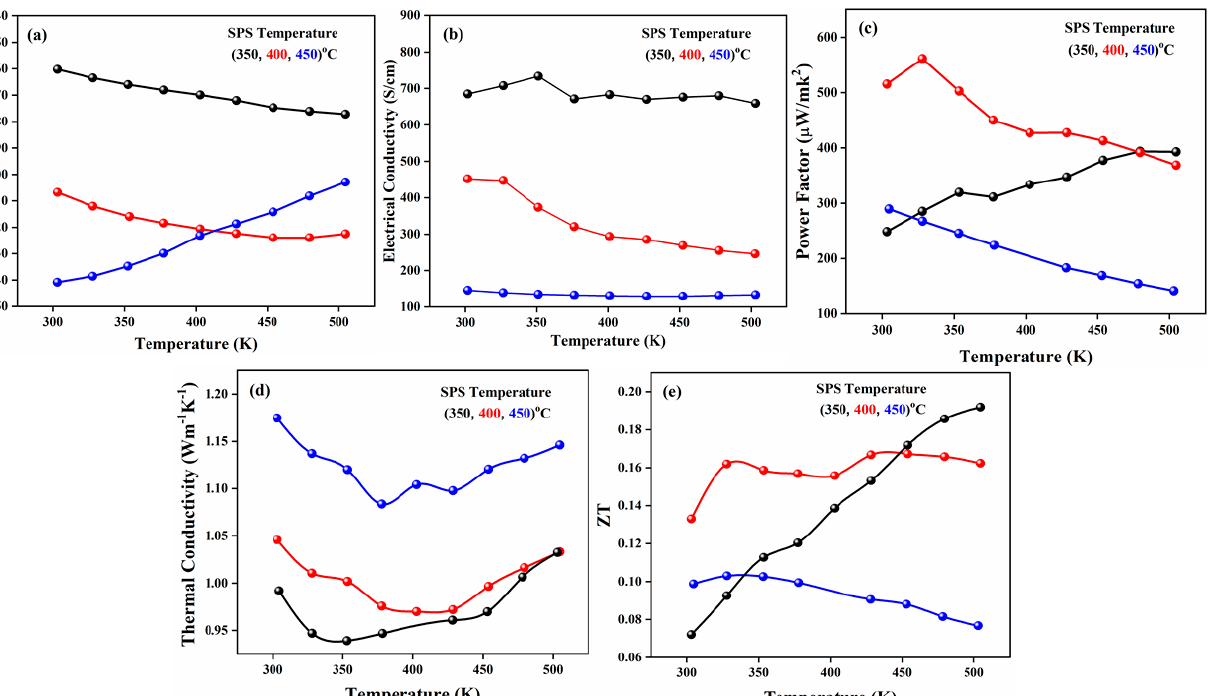
Figure 1. XRD patterns of as-synthesized BT using double solvent sol-gel method, ( a ) Pure BT, where inset shows an image of nanoparticles, ( b ) EDS analysis.